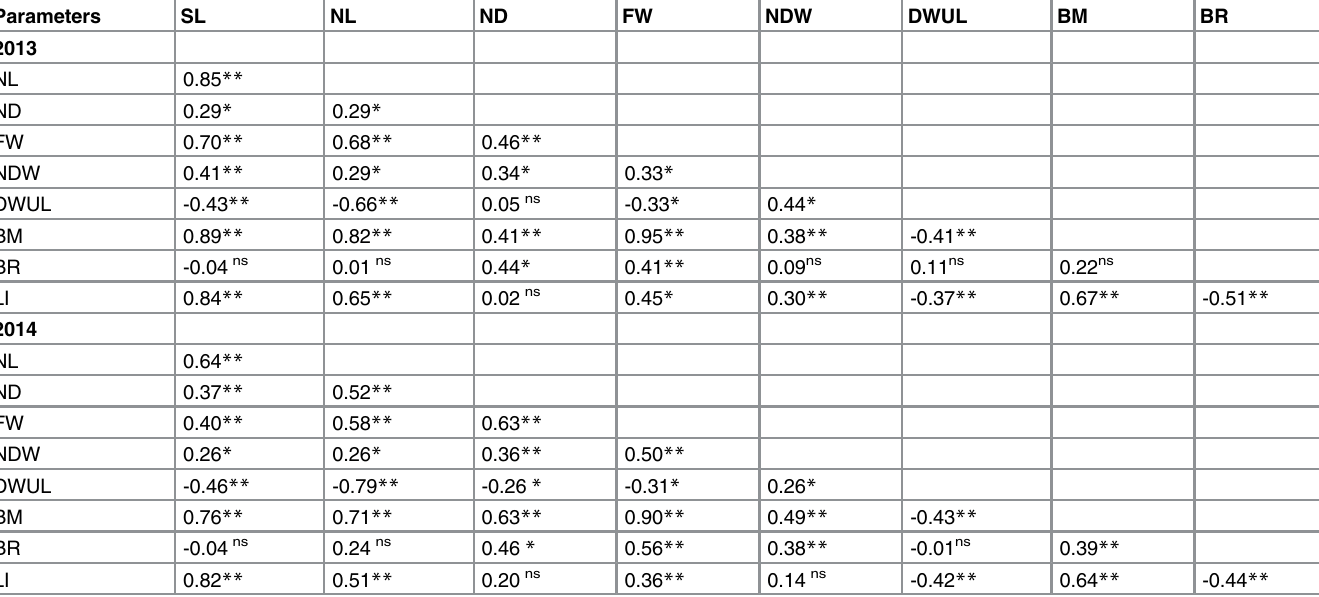
Table 4. Correlation coefficient (r) among lodging-related traits of rice varieties grown in 2013 and 2014 in different ages since 1930s in China. Parameters SL